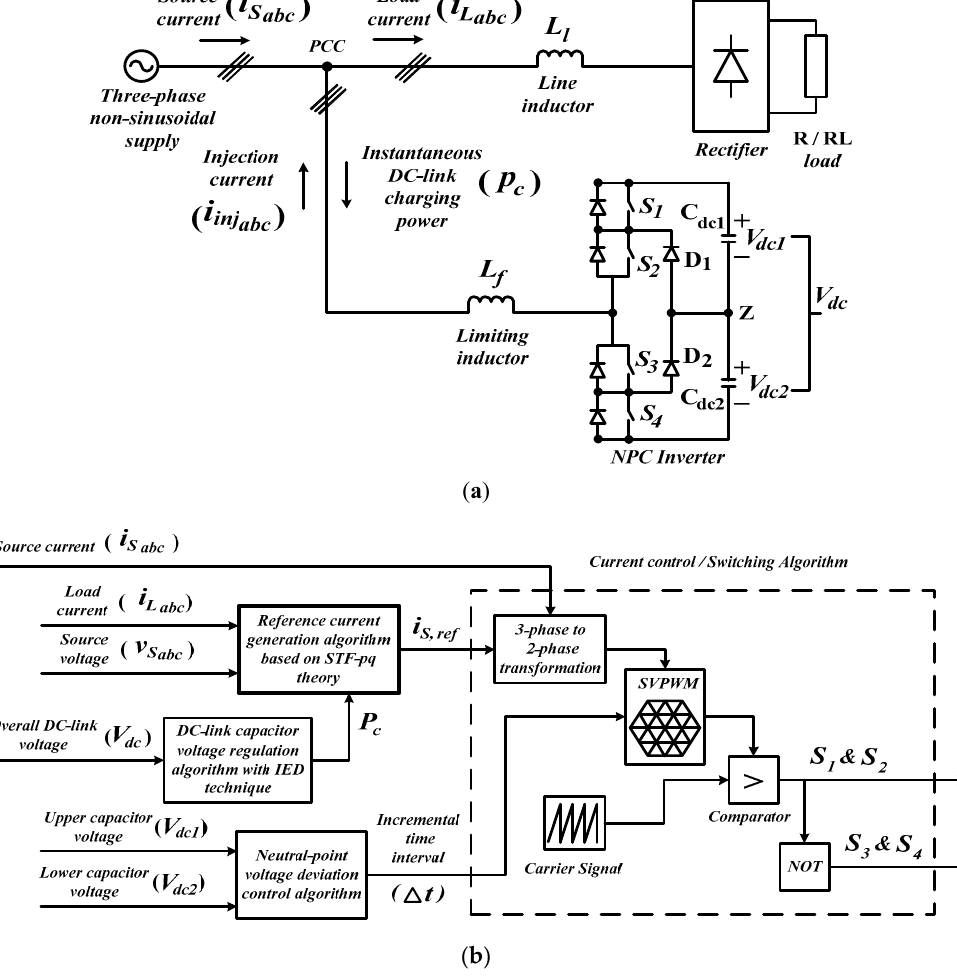
Figure 1. The proposed three-phase three-level NPC inverter-based SAPF: ( a ) circuit configuration and ( b ) control algorithms.